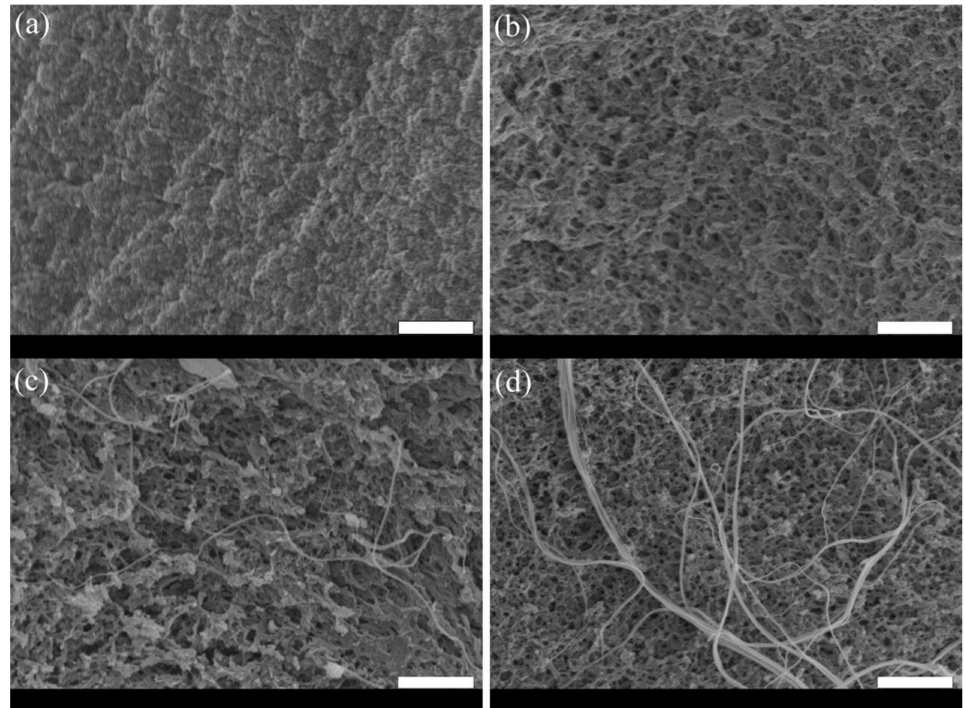
Figure 3. SEM images of the fibrin and fibrin-collagen hydrogels: ( a ) pure fibrin at 20 mg.mL − 1 ; ( b ) fibrin 20 mg.mL − 1 :collagen 2.5 mg.mL − 1 ; ( c ) fibrin 20 mg.mL − 1 :collagen 5 mg.mL − 1 ; ( d ) fibrino- gen 20 mg.mL − 1 :collagen 10 mg.mL − 1 . (scale bar = 2 µ m).